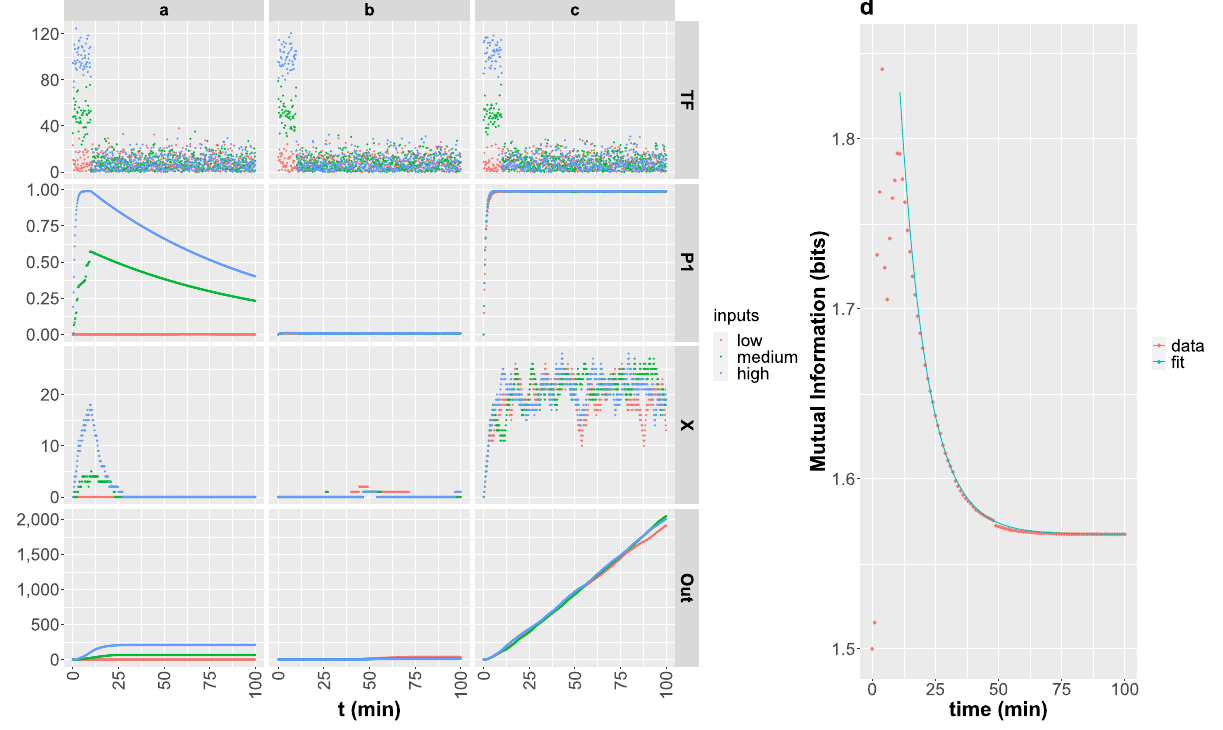
Figure 3. Time course of [ TF ], P 1 , X and Out ( time ) for 3 sets of parameter values ( a – c ) and 3 different amplitudes of TF ( t ) (colors) and the time course of MI for amplitude modulation, the T c time cut and using the kinetic parameters of the example in a ( d ). ( a – c ) In all the simulations, a single TF pulse of 10 min duration was considered. The amplitudes were 0 (red), 10 (green) and 100 (blue) with a superimposed Gaussian distributed noise amplitude of standard deviation, 10. The parameters used in the simulations of the first column were k 1 = 1 / min, k 2 = 100 / min, d 1 = 0.01 / min, Kd = 70 , n = 10 for which the mutual information, computed for the amplitude modulation input type and the output time cut, T c , is MI = 1.56 (i.e. 94% of MI M ). Those of the second column were k 1 = 0.01 / min, k 2 = 1 / min, d 1 = 1 / min, Kd = 10 , n = 1 for which MI = 0.03 , and those of the third: k 1 = 1 / min, k 2 = 100 / min, d 1 = 0.01 / min, Kd = 10 , n = 1 for which MI = 0.02 . ( d ) MI as a function of time computed for amplitude modulated inputs and the T c time cut using the kinetic parameters of the example in a (symbols) and a curve of the form A exp ( − (cid:31) ( t − 10 min )) + MI a that fits the eventual decay to its asymptotic value ∼ MI a = 1.57 bits with (cid:31) = 0.09 / min (solid from MI M for duration modulation and from the conditional minimum, MI m , for amplitude modulation, and viceversa . The parameter, d 1 , on the other hand, can barely be varied to keep MI within 90% of MI M for ampli- tude or duration modulation and differ by less than 10% from MI m for frequency modulation. Overall, we see that keeping MI as small as possible for frequency modulation in each i 2 Minmax region requires to fine tune the time-related parameter values ( k 1 , k 2 and d 1 ) and, in the case of the 12 region, the dissociation constant, K d , as well. As we show in what follows, this fine tuning allows the finding of promoters (characterized by sets of parameter values) that are “blind” to frequency modulated inputs but are good at transmitting information in other modulation types, while the reverse seems to be impossible. We now analyze the difference in information transmission that is achieved when choosing some of the model parameters determined with the Minmax conditioning. This is illustrated in Fig. 6a where we show the MI values obtained for the i and j input modes using a parameter set in the ij Minmax region, for all six ij pairs. The parameters are those that minimize MI for one input modulation type while still being within 90% of the other’s maximum (plotted with circles in Fig. 5). We observe that MI , for duration modulation, has approximately the same value ( ∼ 1.3 to 1.4) for all combinations, including those for which MI by duration is minimized. Given that each set of parameters corresponds to a different promoter, this implies that durations are always equally discriminated regardless of the promoter. In contrast, frequency modulation is the most sensitive mode with MI variations of almost one bit depending on the parameters that characterize the promoter ( MI ∼ 0.8 for the sets depicted in red or blue and MI ∼ 1.7 for those depicted in orange or cyan). The situation for amplitude modula- tion is intermediate with variations of ∼ 0.5 bits ( MI ∼ 1.1 for the parameters depicted in brown or cyan while MI ∼ 1.5 for those in green or blue). These results indicate that it should be possible to find promoters that, being regulated by one TF, are good at decoding duration or amplitude encoded inputs and, at the same time, be “blind” to frequency modulated ones, but that the separation of behaviors would not be as clear in the opposite situation, especially in the case of the combination frequency-duration. We now analyze how the discriminating ability is reflected in the amount of mRNA that is produced using some examples (Fig. 6).